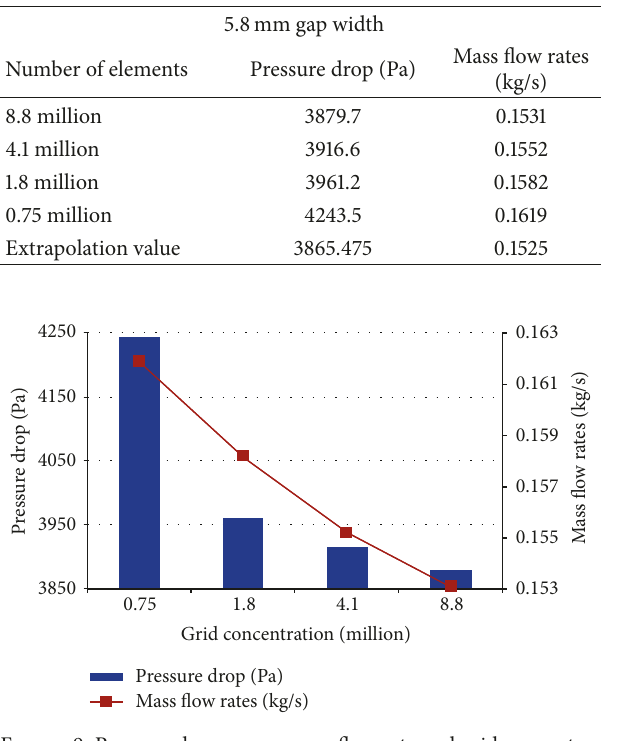
Figure 9: Pressure drop versus mass flow rate and grid concentra- tion.